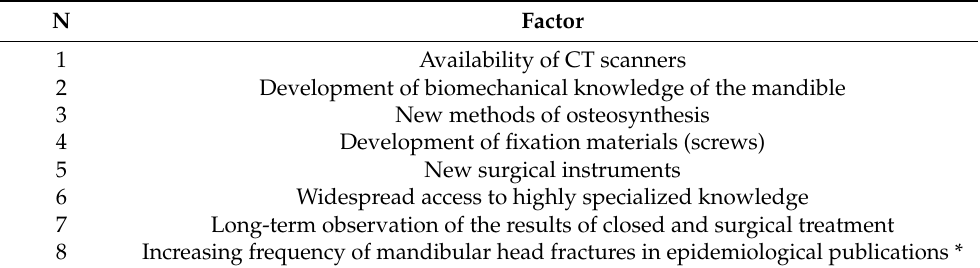
Table 4. Factors contributing to the real proportion of mandibular head fractures in published studies.